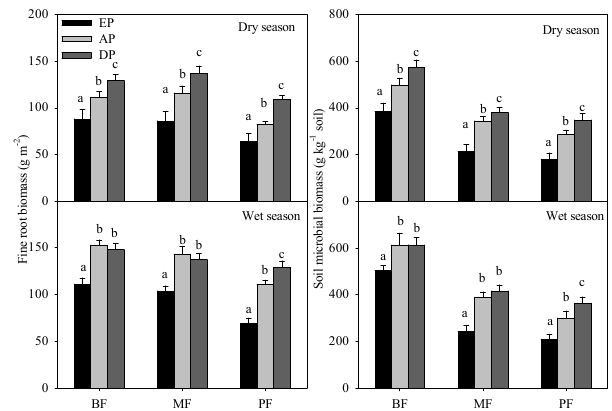
Fig. 4. Mean values of fine root biomass and soil microbial biomass under different seasons and different precipitation treatments at the DNR forests. The treatments are as follows: precipitation exclusion (EP), ambient precipitation (AP), and double precipitation (DP). The forests are as follows: broadleaf forest (BF), mixed forest (MF), and pine forest (PF). Error bars are standard